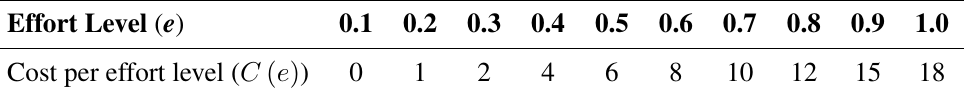
Table 1. Effort levels and effort